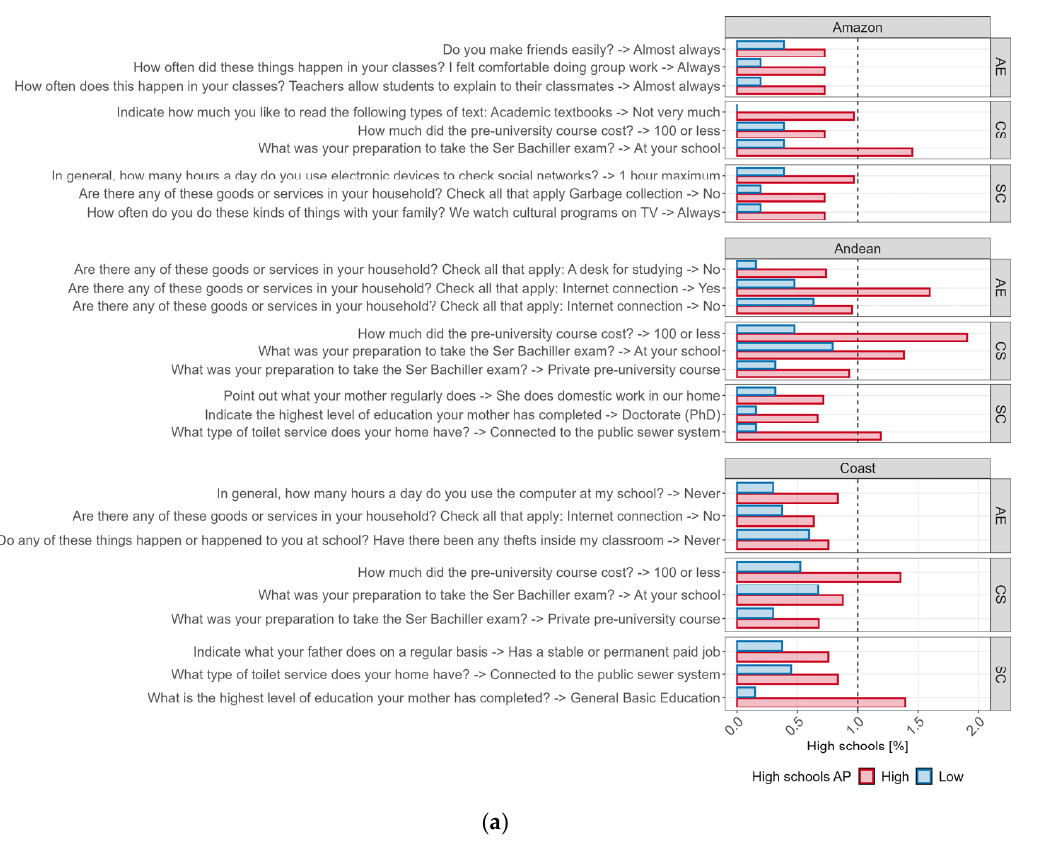
( b ) Figure 7. Frequent answers to survey questions derived from feature selection with the Boruta al- gorithm for ( a ) high and ( b ) low academic performance (AP) classifications. Answers are organized according to region and theme group.